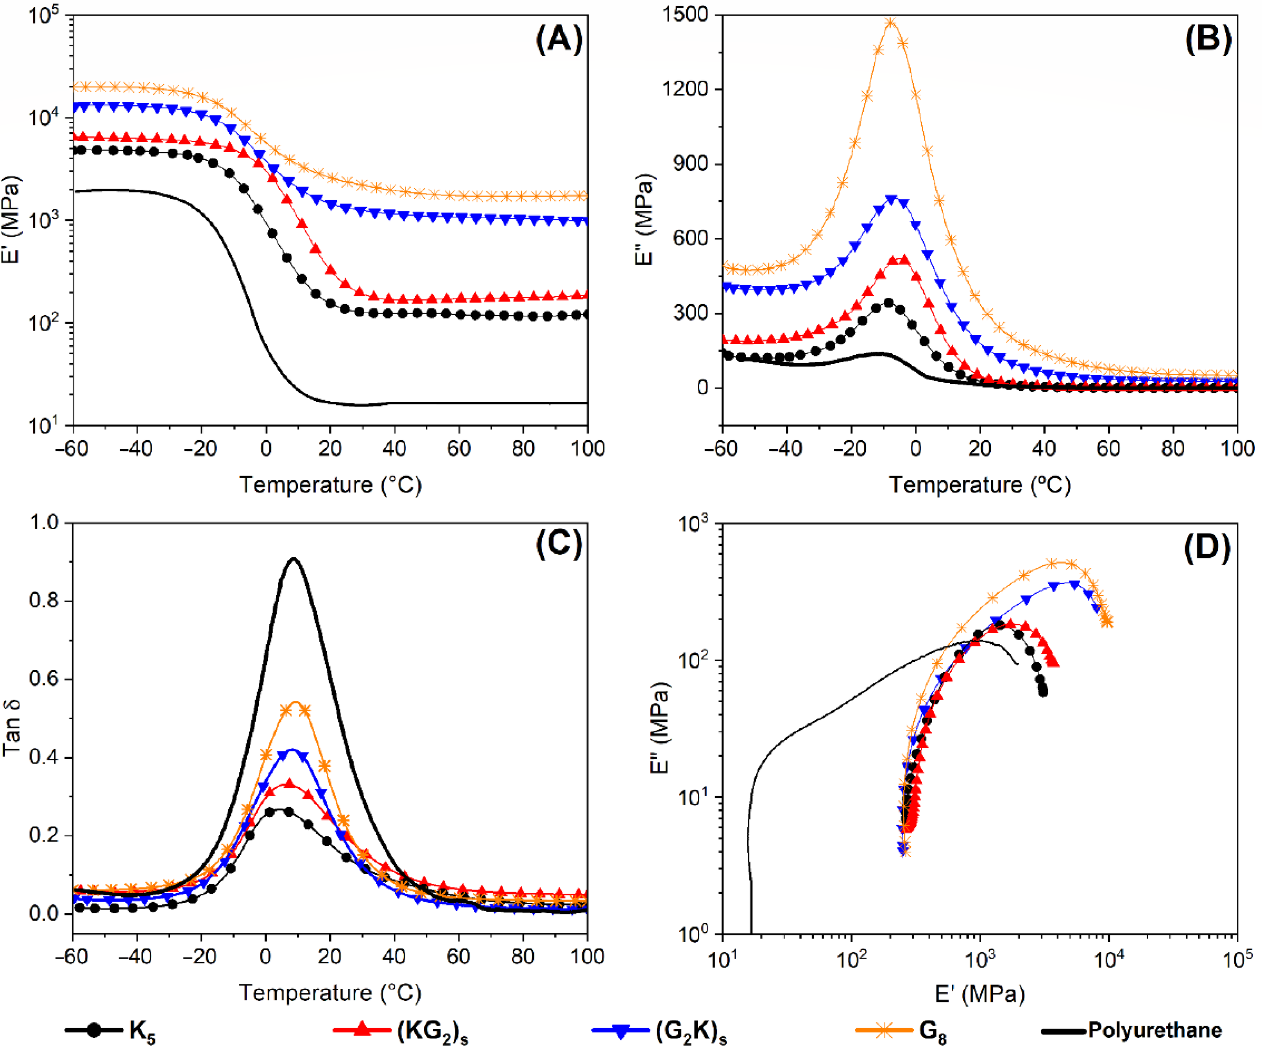
Figure 6. DMA results for PU and laminates: ( A ) storage modulus; ( B ) loss modulus, ( C ) tan δ , and ( D ) Cole-Cole curves. Table 3. Compilation of results from DMA curves shown in Figure 6.